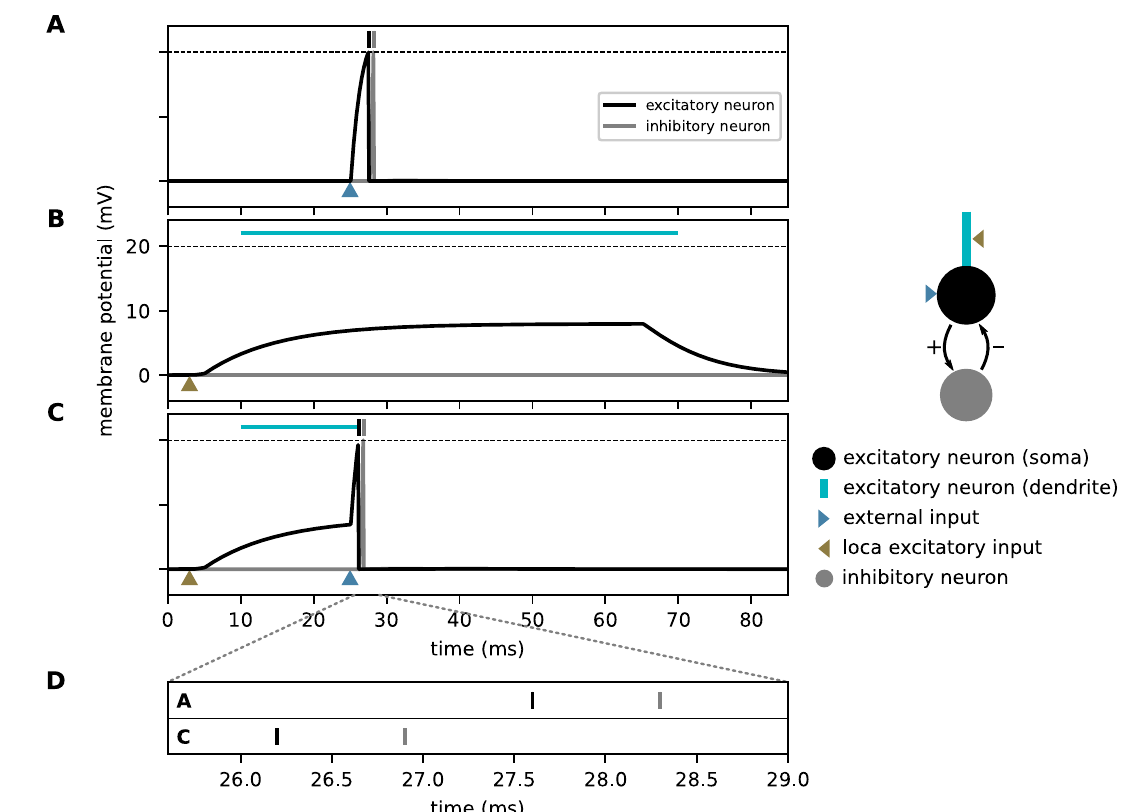
Fig 3. Effect of dendritic action potentials (dAP) on the firing response to an external stimulus. Membrane-potential responses to an external input (blue arrow, A ), a strong dendritic input (brown arrow, B ) triggering a dAP, and a combination of both ( C ). Black and gray vertical bars mark times of excitatory and inhibitory spikes, respectively. The horizontal dashed line marks the spike threshold θ E . The horizontal light blue lines depict the dAP plateau. D) Magnified view of spike times from panels A and C. A dAP preceding the external input (as in panel C) can speed up somatic, and hence, inhibitory firing, provided the time interval between the dAP and the external input is in the right range. The excitatory neuron is connected bidirectionally to an inhibitory neuron (see sketch on the right).